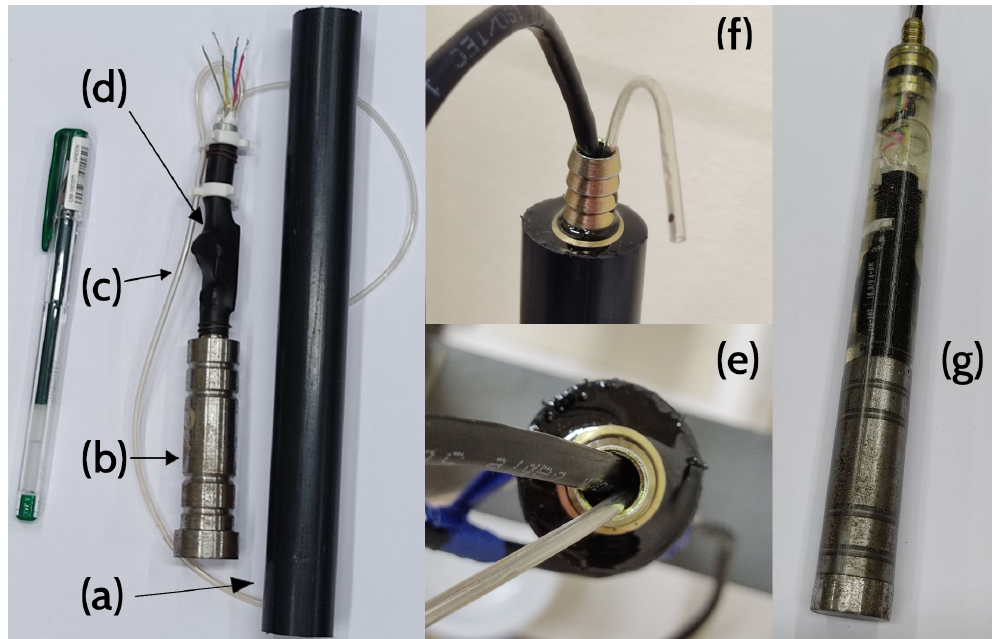
Figure A3. Exploded view of the housing components of the water table probe: ( a ) One-inch plastic tube to contain the crystal epoxy resin during the filling process. ( b ) Steel ballast. ( c ) Nasogastric tube for water pressure. ( d ) Heat-shrink tubing to protect pressure sensor. ( e , f ) Crystal epoxy resin filling process. ( g ) Water table probe ready.